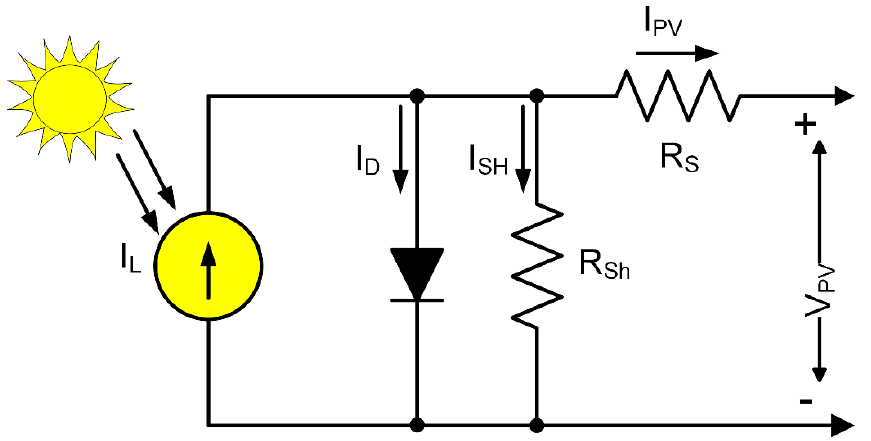
Figure 1. The equivalent electrical circuit of a single diode solar PV cell [30,34].